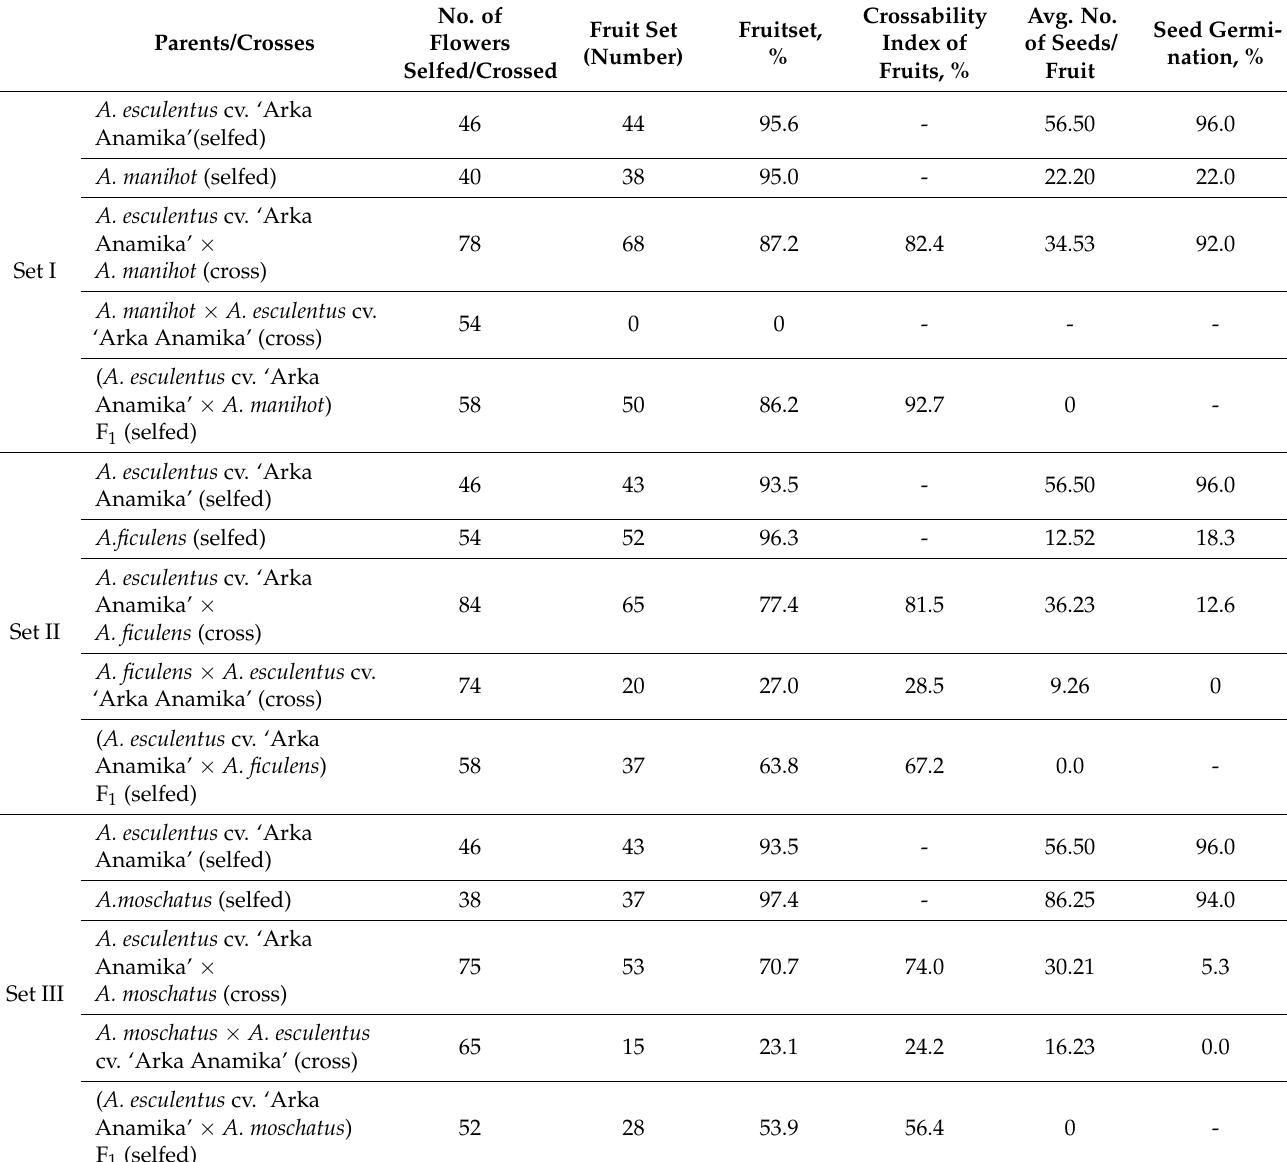
A. esculentus and A. manihot were crossed directly ( A. esculentus × A. manihot ) and reciprocally ( A. manihot × A. esculentus ). Successful fruit set and seed set were seen only in direct crosses. In contrast, the reciprocal cross failed to produce any fruit and seed, leaving all crossability indices at zero. The direct cross recorded 87.2% fruit set, an average of 34.53 seeds per fruit and 82.4% crossing efficiency with 92% F 1 seed germination. Crossability estimates were higher when A. esculentus was used as a seed parent with A. ficulens than in the reciprocal crosses. The direct crosses exhibited 77.4% fruit set with an average of 36.23 per fruit. A higher crossability index of 81.5% with 12.6% seed germination was observed in F 1 . In comparison, the reciprocal cross showed 27% fruit set and an